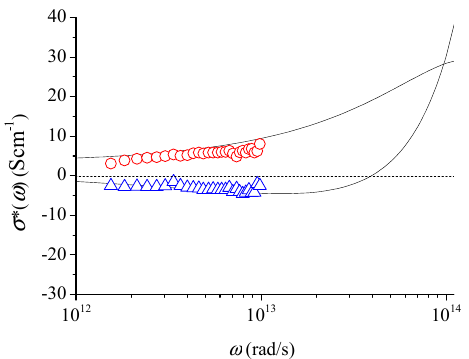
Figure 5. Complex conductivity in nanostructured ZnO films. Open circles and triangles, respectively, are the experimental data extracted from [17]. Solid lines are conductivity predicted from the SSFTC model.